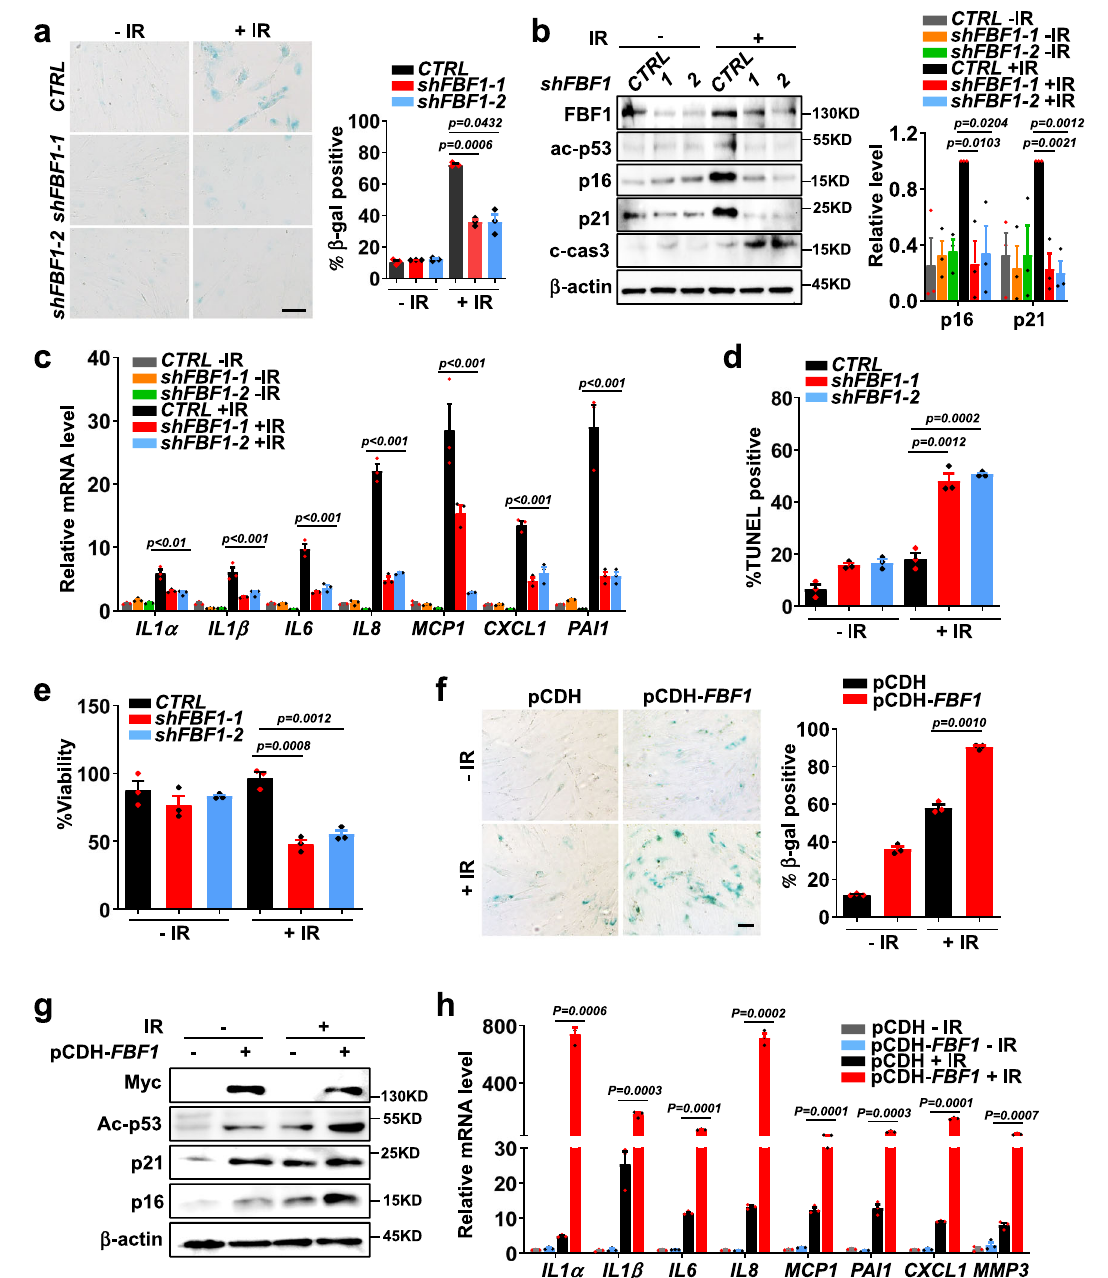
Fig.2|Transition fi bercomponentFBF1isakeyplayerinDNAdamage-induced senescence.a – c SA- β -galstaining(n>100cellsperexperiment)( a ),westernblotof senescencemarkers( b ) and relative mRNAlevelsof SASPgenes ( c ) in IMR-90 cells stablyexpressingcontrolshRNAorsh FBF1